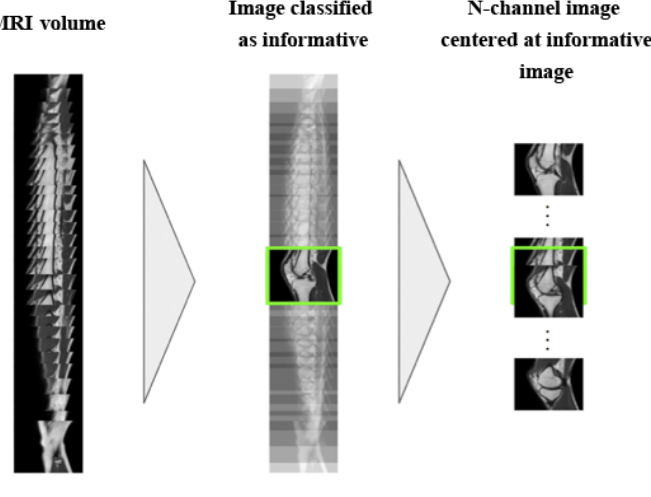
Figure 3. Example of how an N-channel image is created from one of the images in the magnetic resonance imaging (MRI) volume classified as